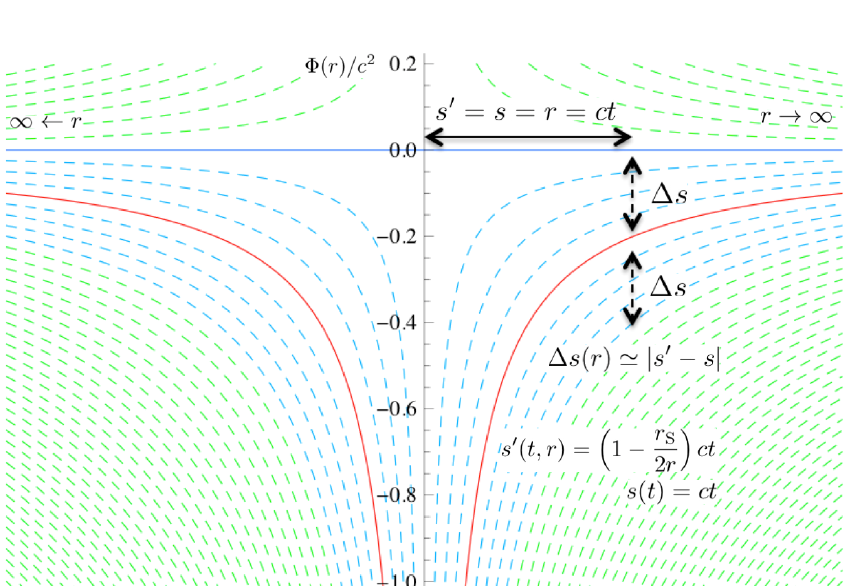
Figure 3. We assume that, quantum mechanically, space-time exists in a superposition of states. If, classically , the presence of a particle of mass m at r = 0 induces a perturbation in the background space-time, of magnitude ∆ s pert ( r , m ) = | s (cid:48) ( r , m ) − s ( r ) | , the spread of space-time states in the quantum superposition is of order ∆ s ( r , m ) (cid:39) ∆ s pert ( r , m ) . In this picture, the solid blue line represents the unperturbed geometry s ( r ) and the solid red line represents the perturbed geometry s (cid:48) ( r , m ) . Dashed blue lines represent states in the quantum superposition with non-negligible amplitudes, whereas dashed green lines represent highly improbable states. Typically, these correspond to flat, or even negative curvature in the presence of m (upper half-plane), or to extreme positive curvature that could only be sourced classically by much higher masses (lower